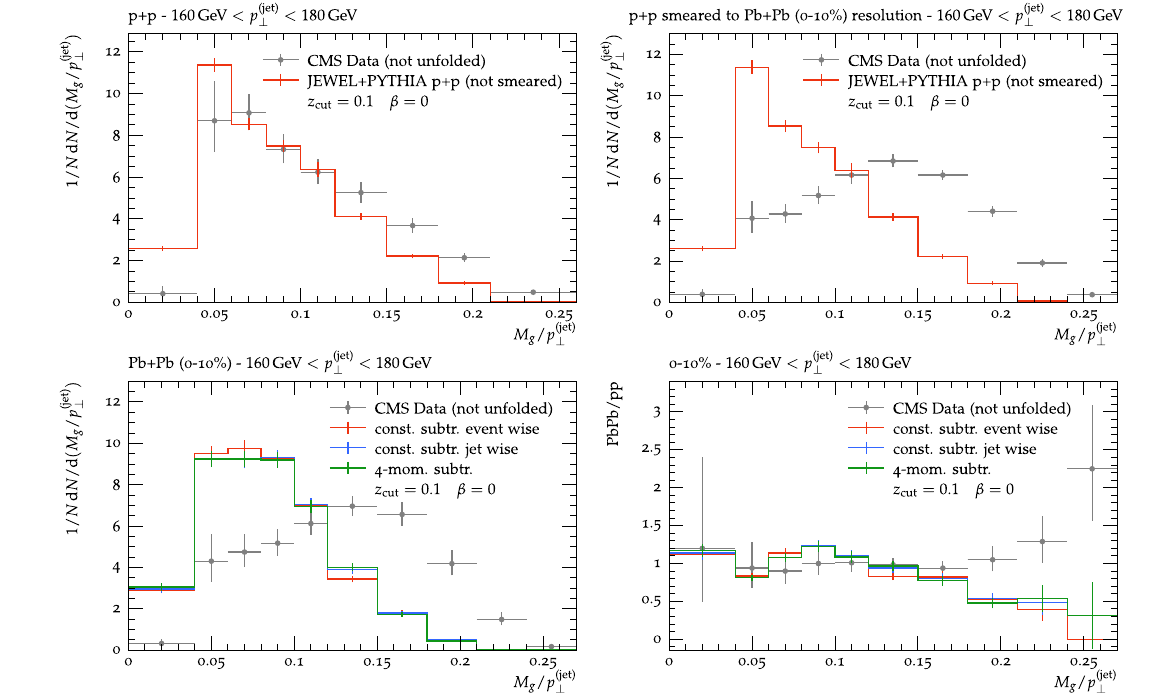
( jet ) < 180 GeV. CMS data [78] and JEWEL+PYTHIA 160 GeV < p ⊥ results with different subtraction methods. The CMS measurement has not been unfolded and the JEWEL+PYTHIA results have not been smeared, so a direct comparison is not